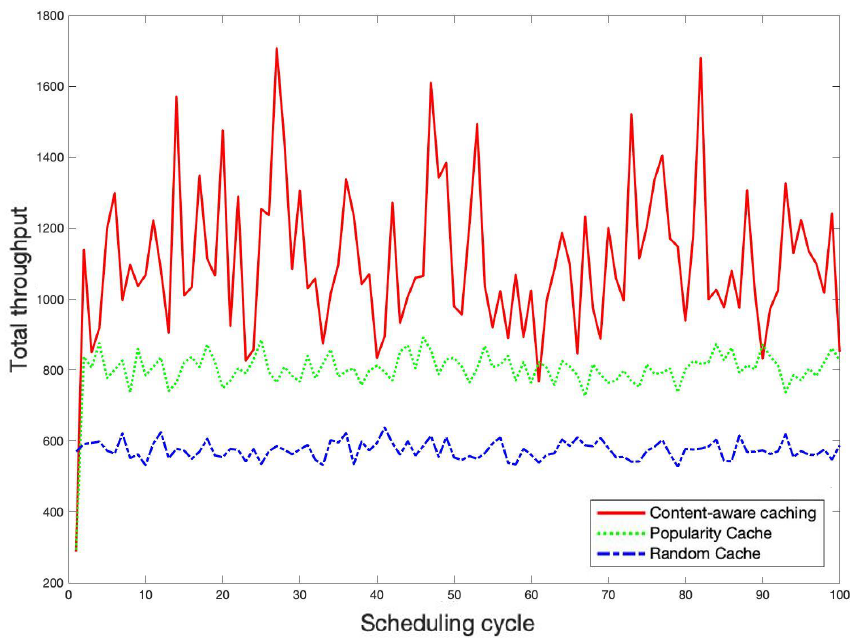
Figure 6. Throughput comparison of different caching